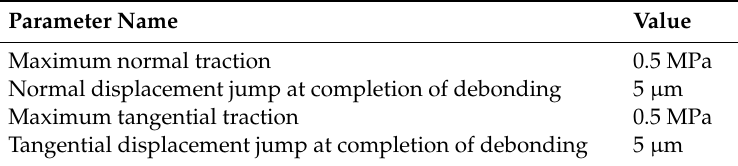
Table 4. Cohesive Zone model (CZM) parameters.